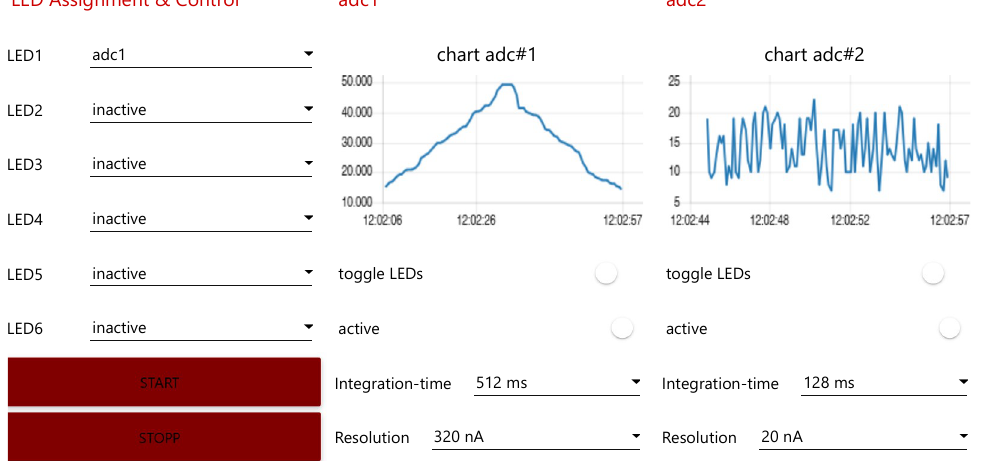
Figure 9. Node-RED Dashboard—Visualization and GUI of the Photometer Digital Twin Recording an Actual Measurement of a skin-like liquid Suspension (adc#1) and Reference Ambient Interference Measurement